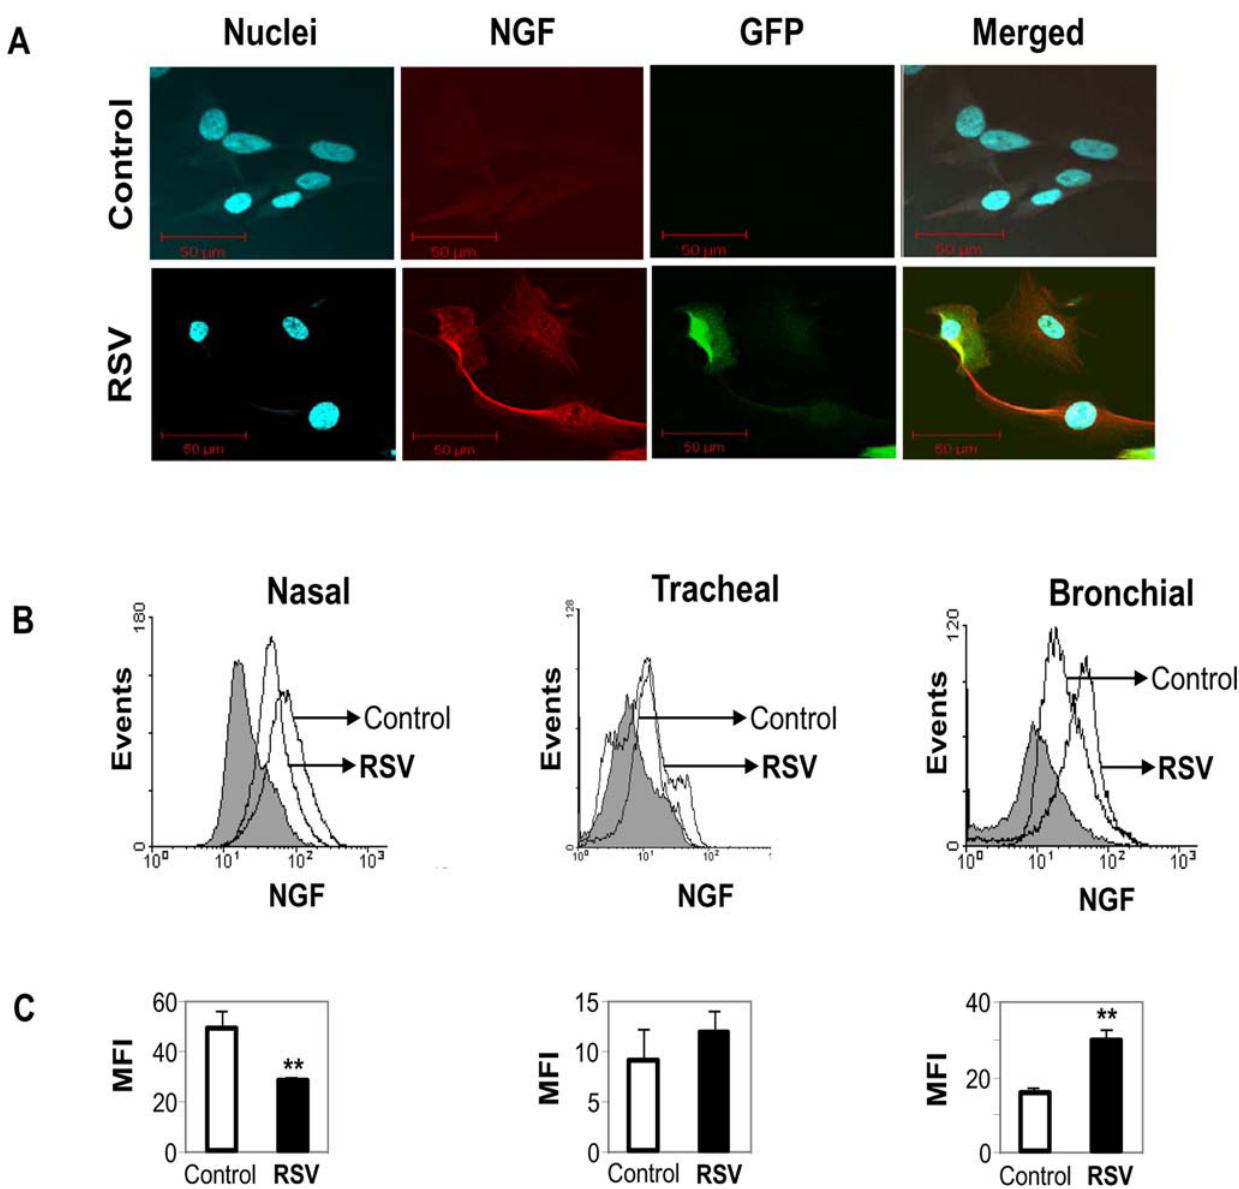
Figure 2. RSV infection modulates NGF expression. (A) RSV-induced NGF overexpression in human bronchial epithelial cells infected for 48 h. Cells were incubated with rabbit polyclonal NGF antibody for 1 h and subsequently treated with a secondary PE-conjugated anti-rabbit antibody. Nuclei were stained with TOPRO-3. Pictures were taken using a confocal microscope having a fluorescence emission of 488 nm for detection of green fluorescent protein (GFP). (B) Changes in NGF protein expression were detected by staining rgRSV-infected or non-infected nasal, tracheal and bronchial epithelial cells with anti-human NGF antibody or a matched isotype control (shaded histogram). Primary antibody binding was detected by incubation with PE-conjugated goat anti-rabbit antibody. (C) Geometric mean fluorescent intensity (MFI) is presented in bar graphs. Data are expressed as the mean 6 SEM (n=4 experiments). **= p , 0.01 compared to non-infected controls.